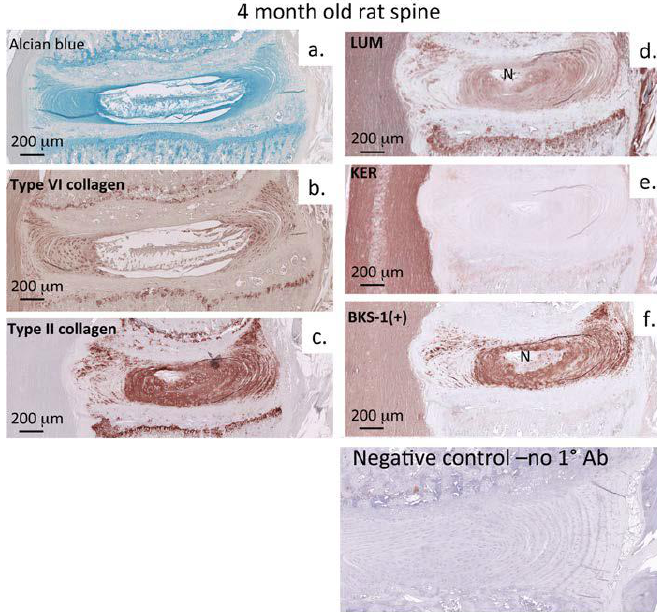
Figure 3. Visualization of the distribution of rat spinal components. Histochemistry / immunohistochemistry of alcian blue proteoglycan ( a ), type VI collagen ( b ), type II collagen ( c ), lumican ( d ), keratocan ( e ), and BKS-I (+) ( f ) in a 4 month old rat spinal segment. Alcian blue and antibodies towards collagen types II and VI have been used to delineate the constituent spinal connective tissues. Lumican is immunolocalized to the nucleus pulposus and inner annulus fibrosus and prominently in the vertebral growth plate cartilages and anterior longitudinal ligament, however keratocan is only weakly immunolocalized to the vertebral growth plate. BKS-1(+) epitope is prominently immunolocalized in the nucleus pulposus, inner annulus fibrosus, and the vertebral growth plates.